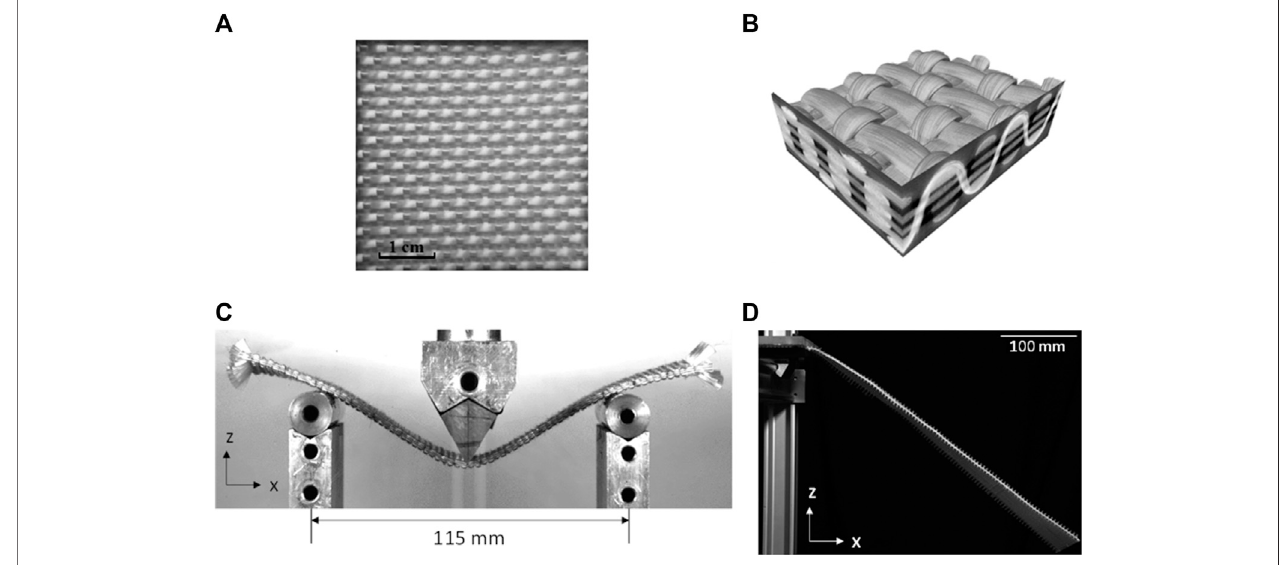
FIGURE3| Glass-based3Dwovenreinforcement: (A) image, (B) 3Dtomographyreconstruction(Naouaretal.,2015). (C) Three-pointbendingtest, (D) Cantilever bending test.